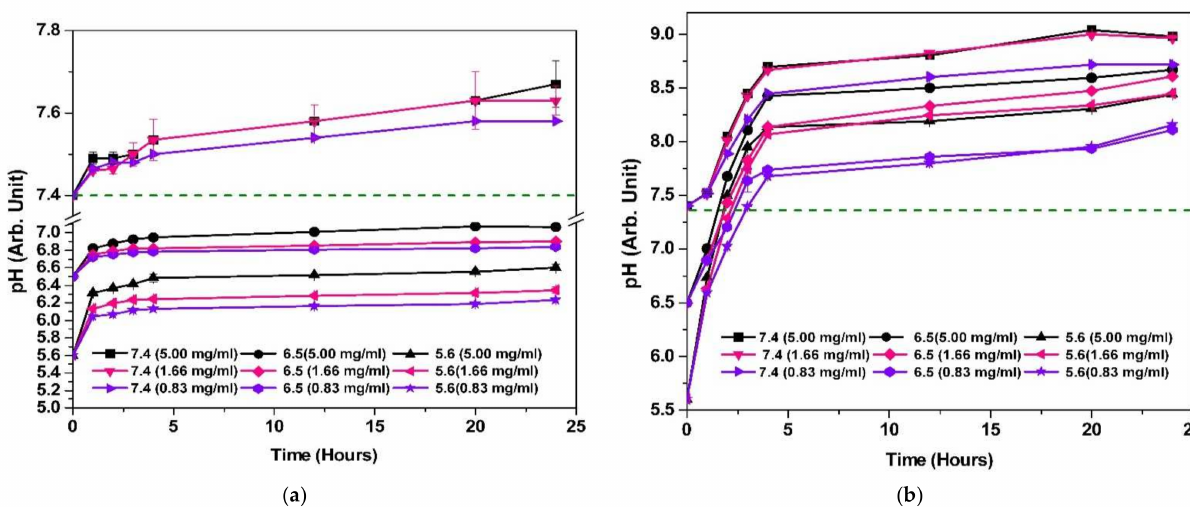
Figure 7. Alkalinization profiles of CSCaCO 3 NP: ( a ) In simulated plasma fluid at pH of 7.4, 6.5 and 5.6 and concentrations of 5.00 mg/mL, 1.66 mg/mL and 0.83 mg/mL (Break in y -axis: 7.12–7.35) and ( b ) In phosphate buffered saline with 0.2% ( v / v ) Tween 80 at pH of 7.4, 6.5 and 5.6 and concentrations of 5.00 mg/mL, 1.66 mg/mL and 0.83 mg/mL. Dotted line indicating the pH of 7.4 in both the